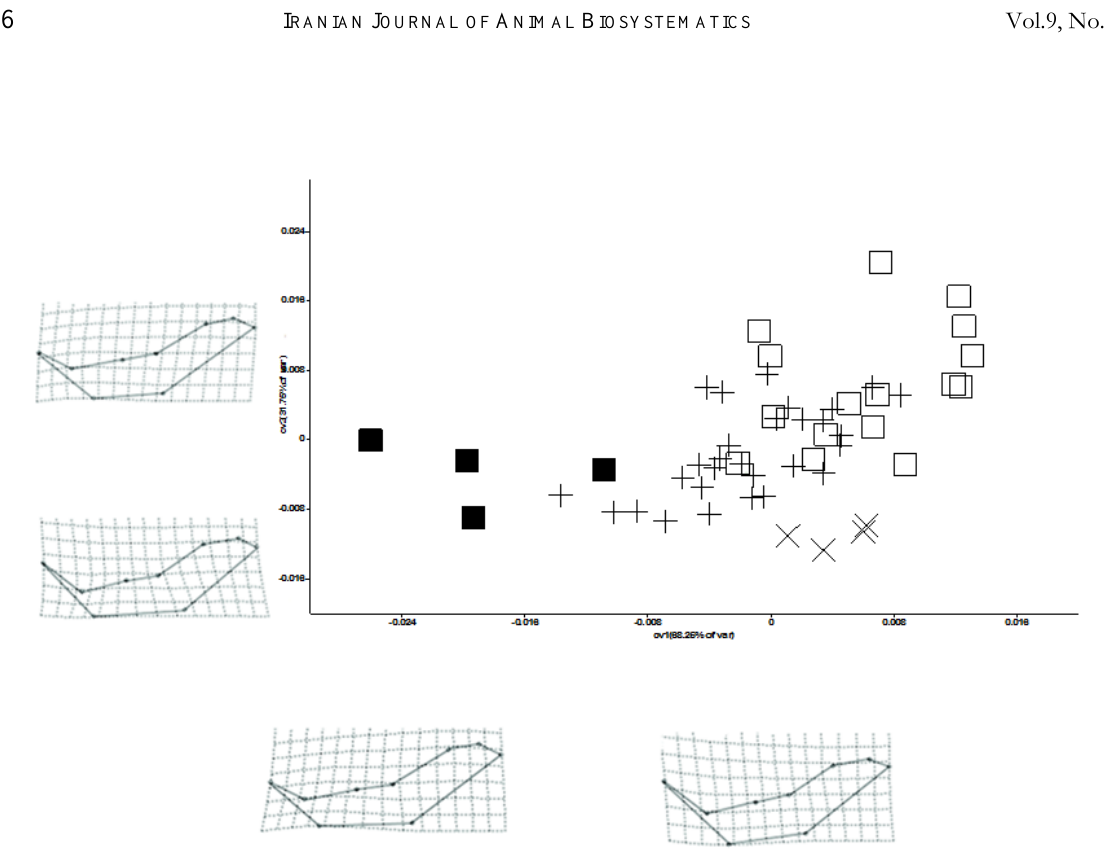
F IGURE 2. Ordination of eleven populations of brush-tailed mice (Calomyscus) in the space of canonical axes 1 and 2 based on the total shape matrix of the mandible. Deformation grids on the extremities of each axis are shown . Solid square: C. hotsoni , Open square: C. bailwardi , Multiply sign : C . grandis , Plus sign: C . elburzensis